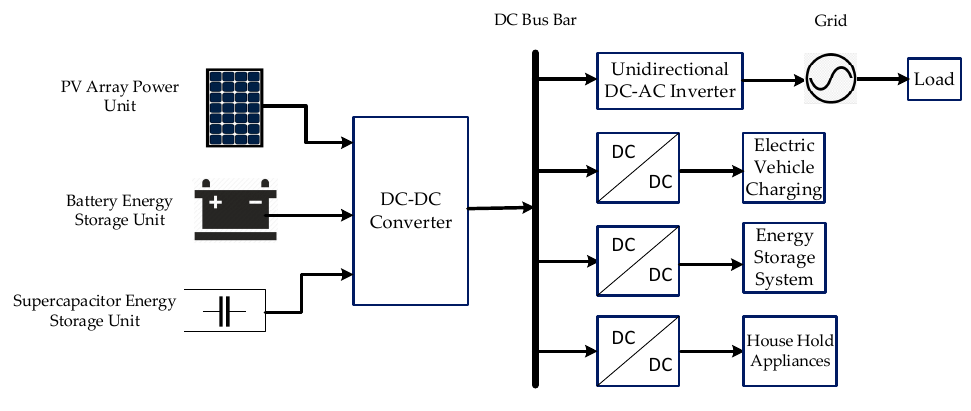
Figure 1. Applications example of DC-DC converters [5].